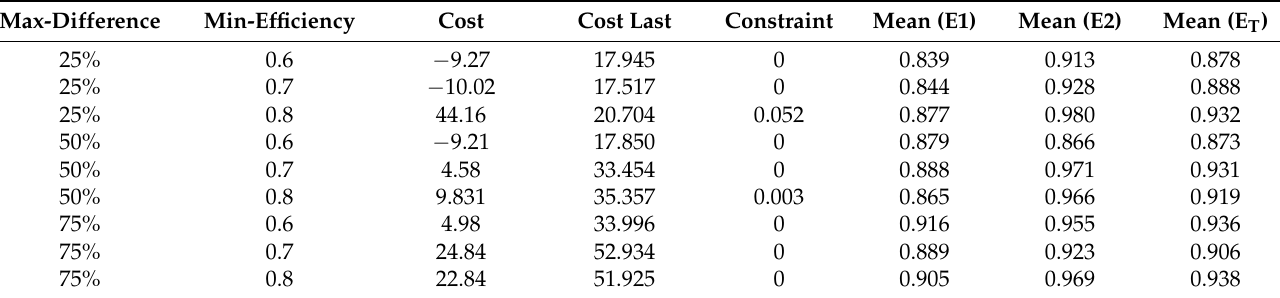
Table 6. Results of different parameters of cost function.